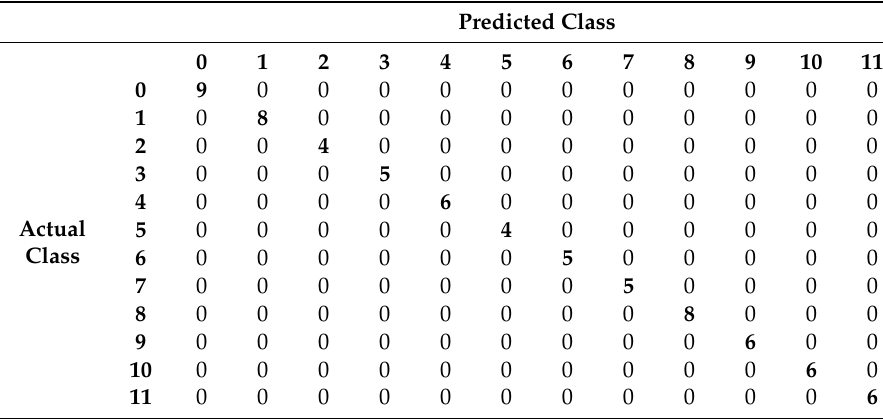
Table 2. Confusion matrix of the LDA model for all the